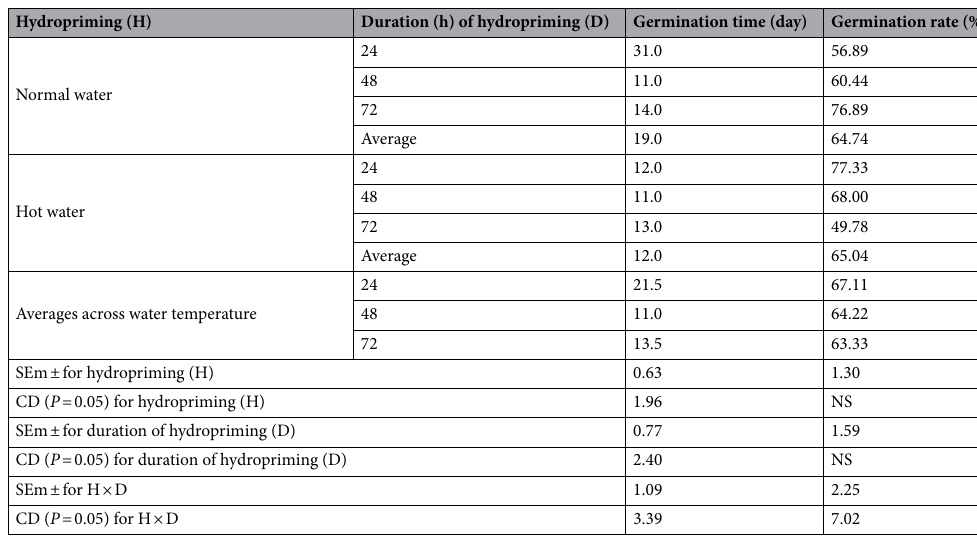
Table 1. Effect of seed stratification on date of sprouting and germination rate of monk